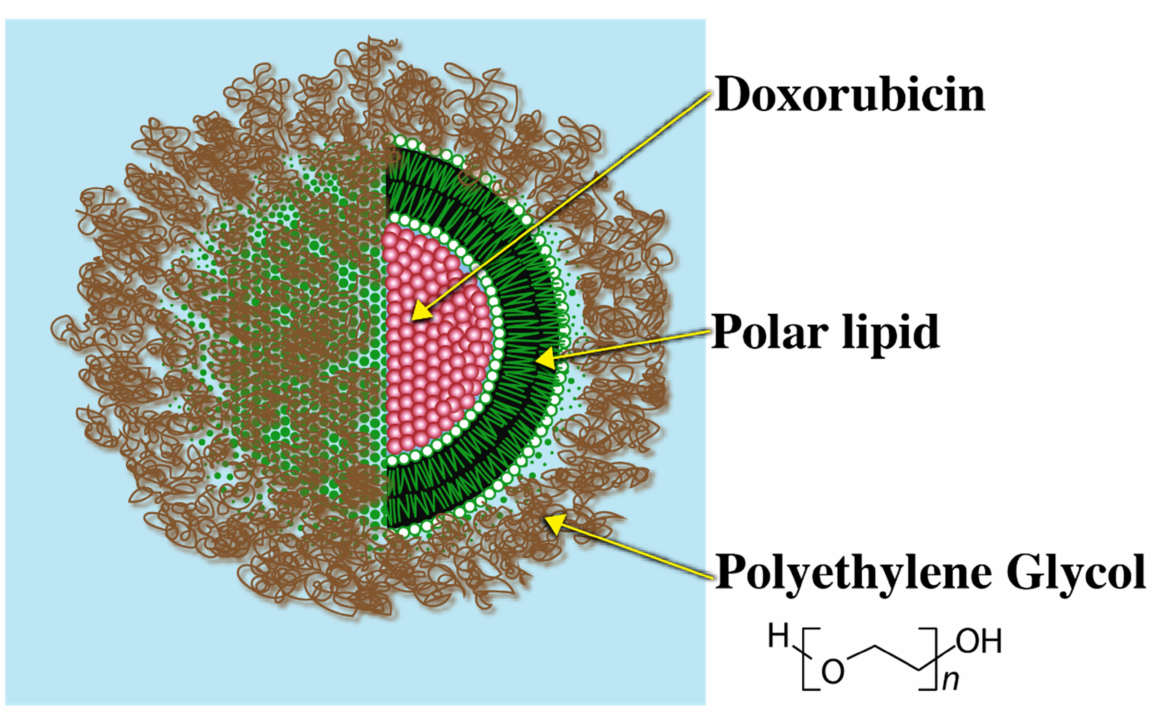
Figure 4. Doxil coated with Polyethylene